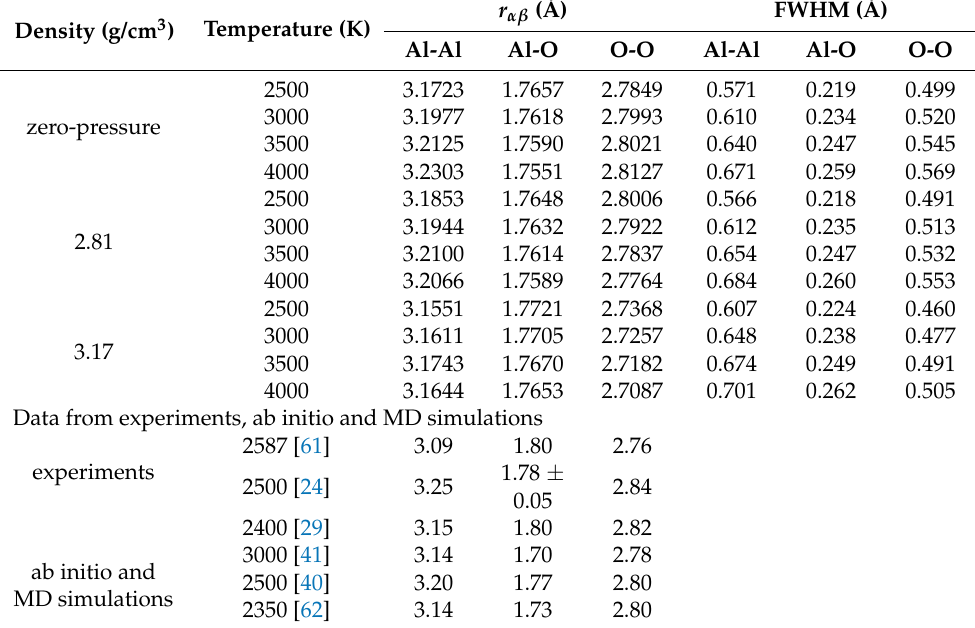
Table 2. Position ( r αβ ) and full width at half maximum (FWHM) of the initial peak in partial pair distribution functions for liquid alumina from this MD simulation and the data from experiments and ab initio simulation.